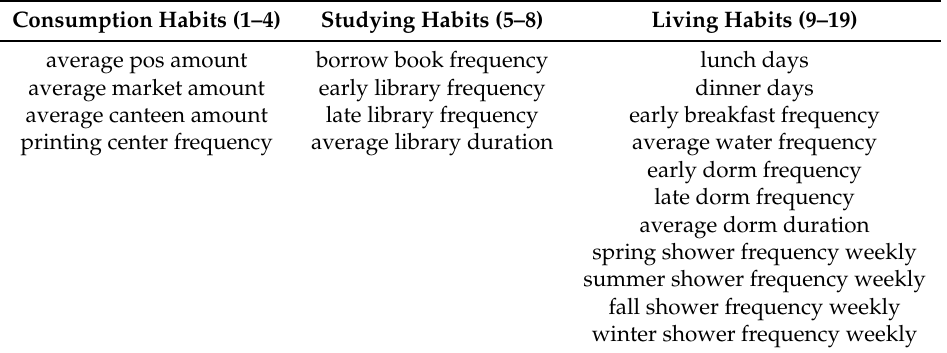
Table 9. Different types of manually extracted